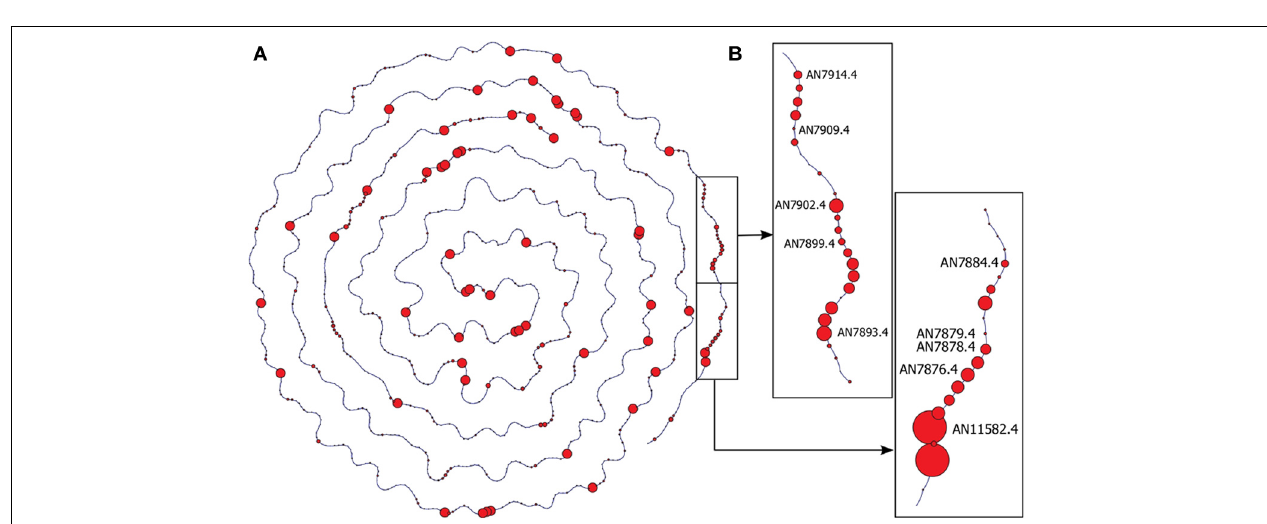
whereas red circular concepts represent genes. An arrow between two gene ontologies reflects the hierarchical structure of the directed acyclic graph of the gene ontologies. An arrow pointing from an ontology concept to a gene concept shows which genes have been assigned to the respective gene ontology concept. In contrast to commonly used pie and bar chart diagrams, the visualization within Ondex allows to explore possible multiple mappings between genes and ontologies without losing the information about the level of detail at which the mapping occurs.